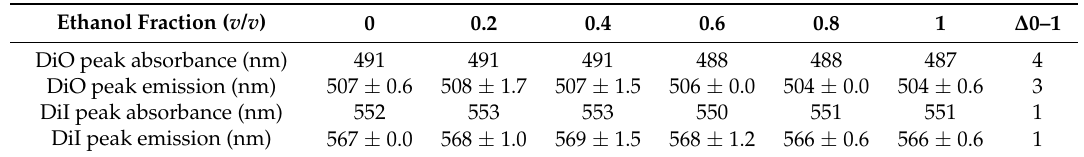
Figure A3. Emission spectra of fluorescently labelled nanocarriers at a. excitation at λ = 484 nm and emission at λ = 505 nm (donor excitation and emission) and b. excitation at λ = 484 nm and emission at λ = 568 nm (donor excitation and acceptor emission) over time at 37 °C. All nanocarriers were diluted to equivalent dye concentrations of 0.158 µM in PBS and samples that indicate addition of enzymes contained 0.1 mg/mL pancreatin. Small dashed lines above and below mean lines indicate standard deviation from three independent measurements. Table A2. Peak absorbance/peak emission of 1.59 µM DiO/DiI NCs (1:100 dilution) at different ethanol fractions in water (see full emission spectra in Figure A2).